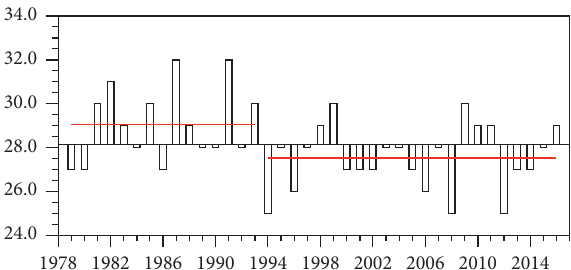
Figure 1: Time series of the MTG-defined SCSSM onset date with the red line denoting the mean epoch